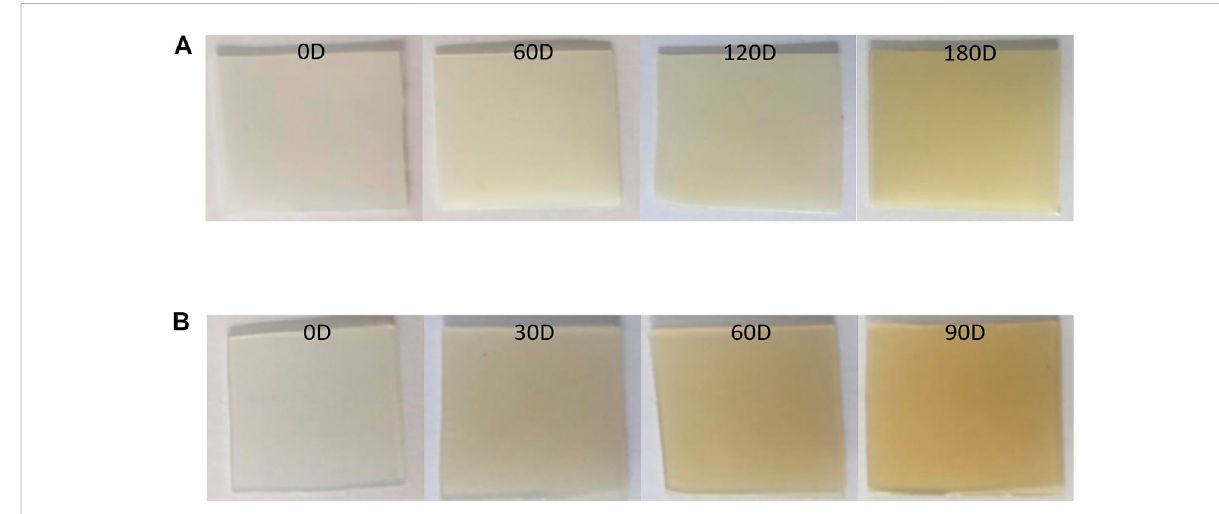
FIGURE 7 Changes in the appearance of two materials with aging time: (A) 70L – 30H and (B) XLPE.